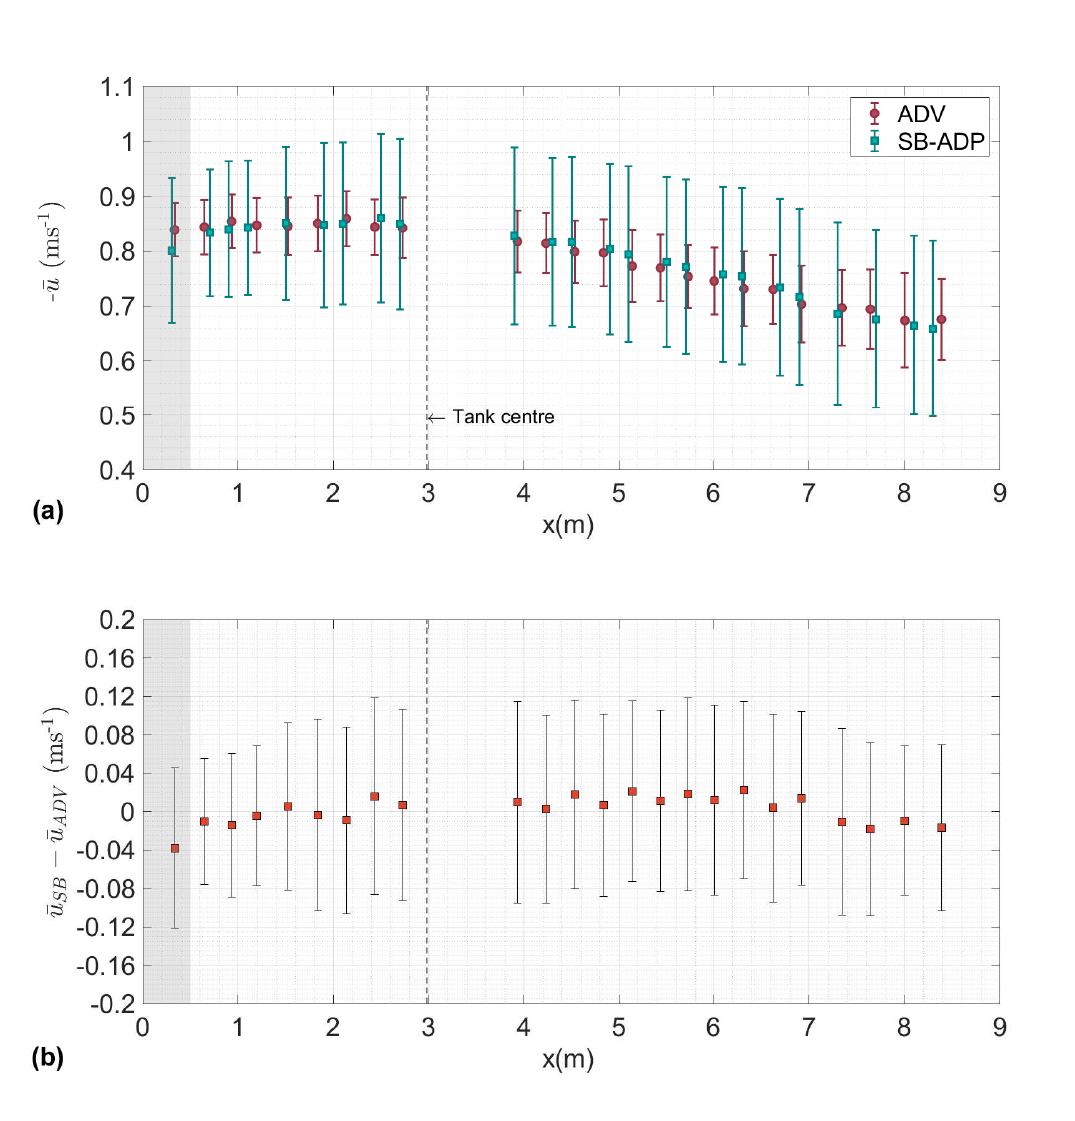
Figure 4. ( a ) Mean and standard deviation of the flow measured by the ADV from the SuperGen Marine tidal array project [8,29] and the SB-ADP at the cell centre for a tank nominal flow velocity of 0.8 ms − 1 and ( b ) difference in measured mean velocities between the ADV ( ¯ u ADV ) and SB-ADP ( ¯ u SB ) with the difference in standard deviation. SB-ADP ( ¯ u SB and ¯ u ADV ) are negative due to the flow direction. The shaded area represent the region affected by the proximity to the instrument and only points with measurements conducted with both instruments are